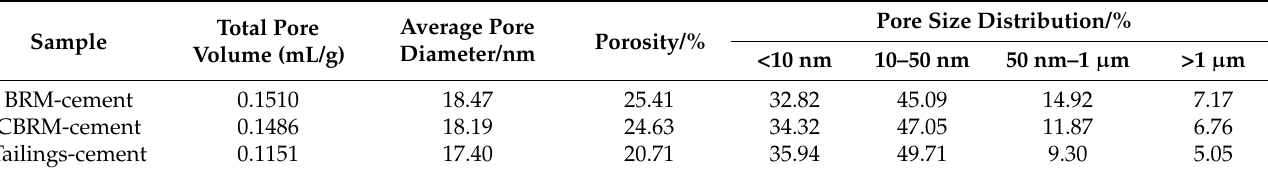
Table 5. Detailed data of pore structure.